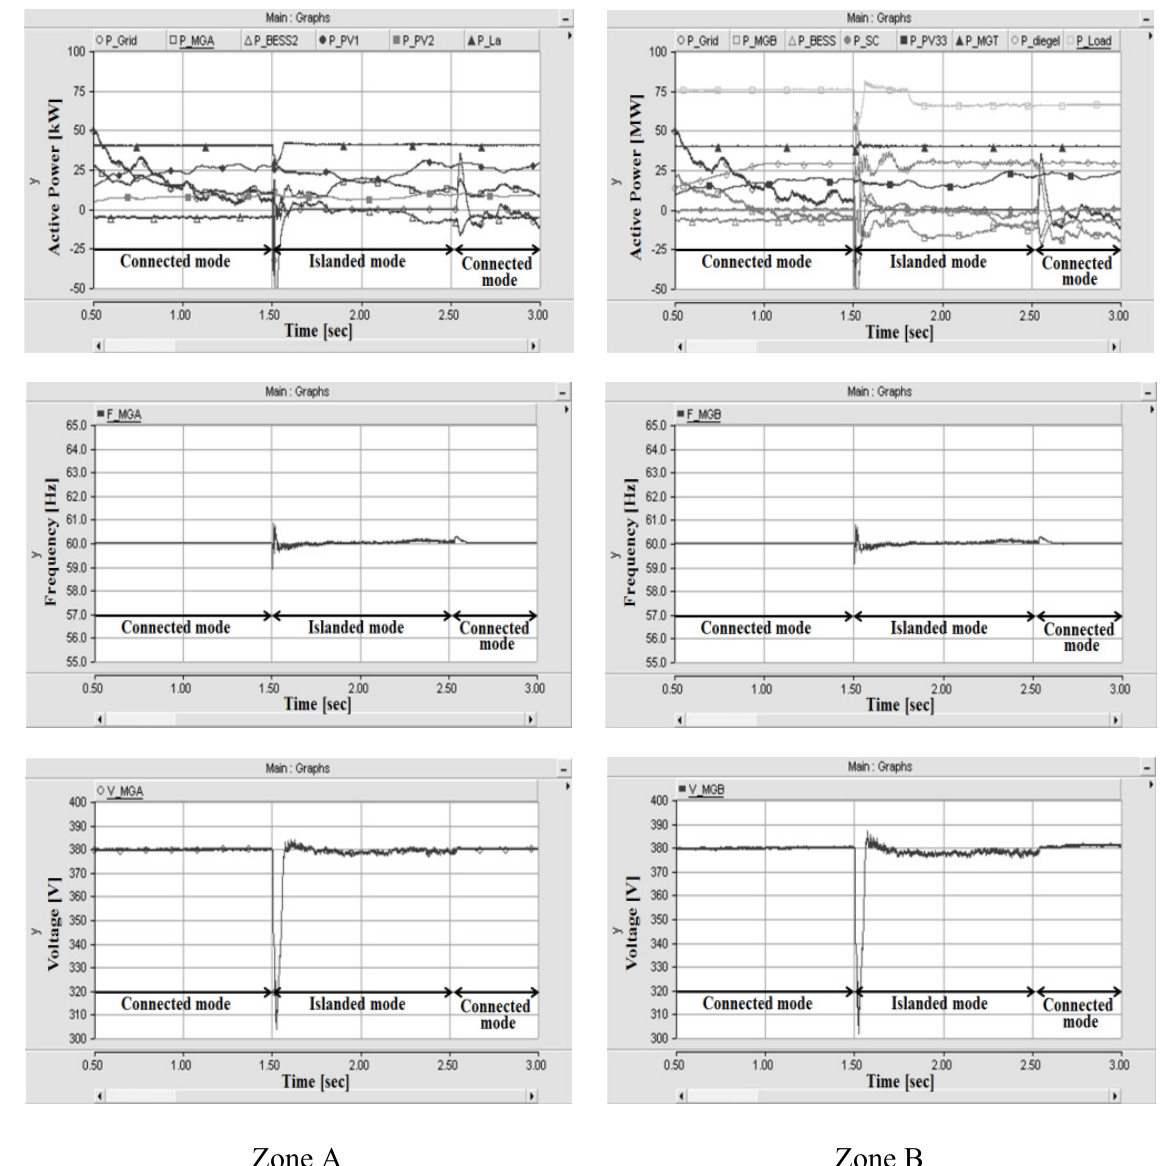
Figure 8. Active power, frequency and voltage in microgrid (Zones A and B) about Case 4, 5 and 6 respectively. ( a ) Case 4, External Fault; ( b ) Case 5, Feeder Fault with BESS in Zone B; ( c ) Case 6, Feeder Fault with PV in Zone